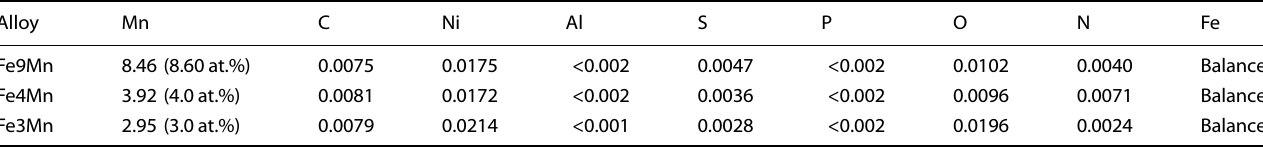
Table 2. The composition of the alloys studied in this